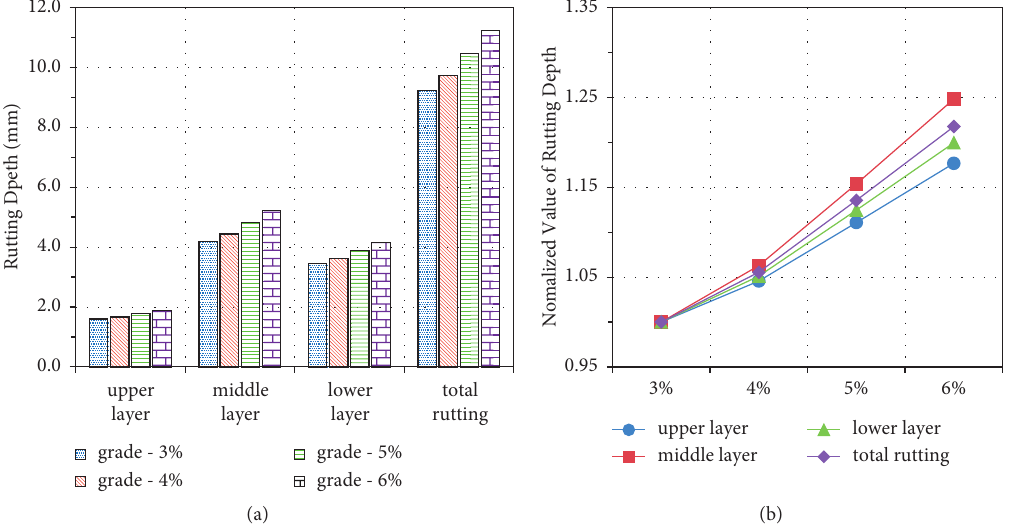
Figure 15: Rutting depth under different gradients: (a) normal value and (b) standardized